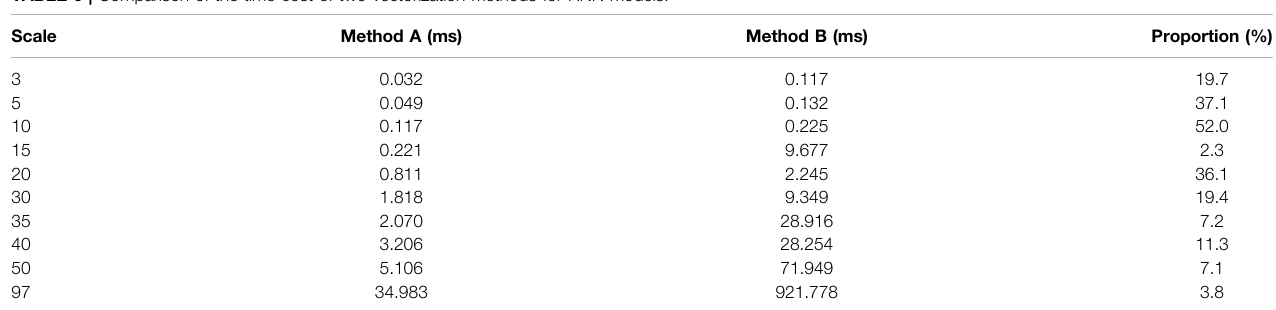
TABLE 6 | Comparison of the time cost of two vectorization methods for RNN models.